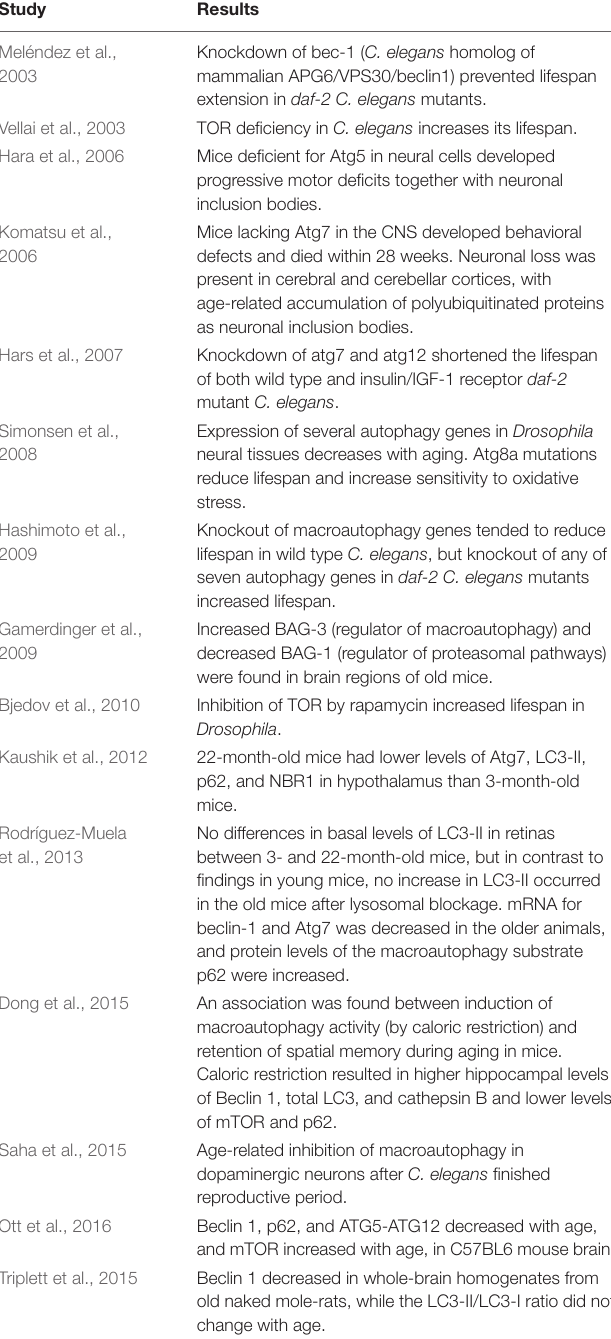
TABLE 2 | Influence of normal aging on CNS macroautophagy in experimental